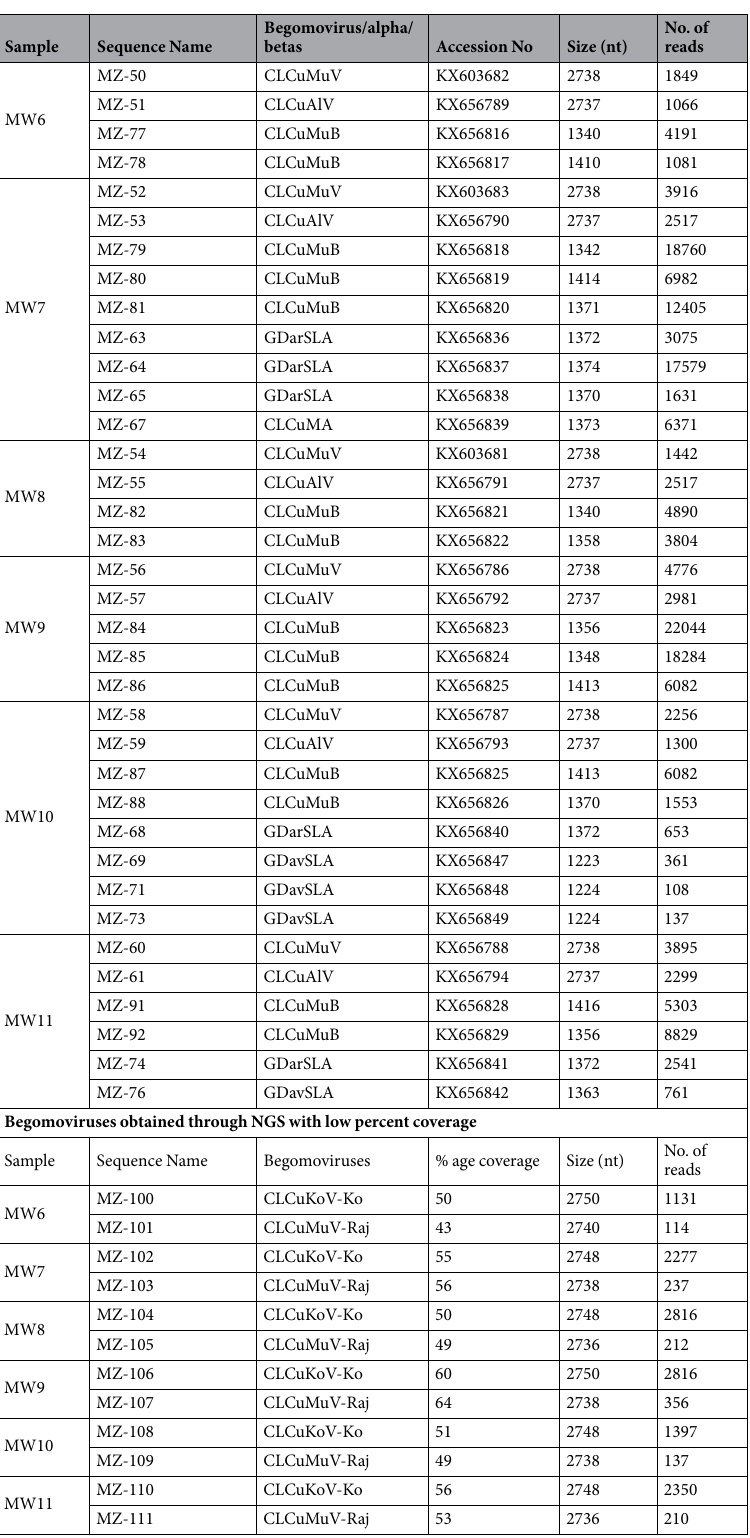
Table 1. Begomoviruses, betasatellites and alphasatellites obtained from infected cotton samples through